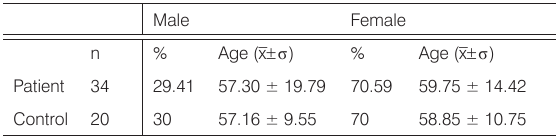
Table 1. The Distribution of the Patient and Control Groups Accord- ing to Age and